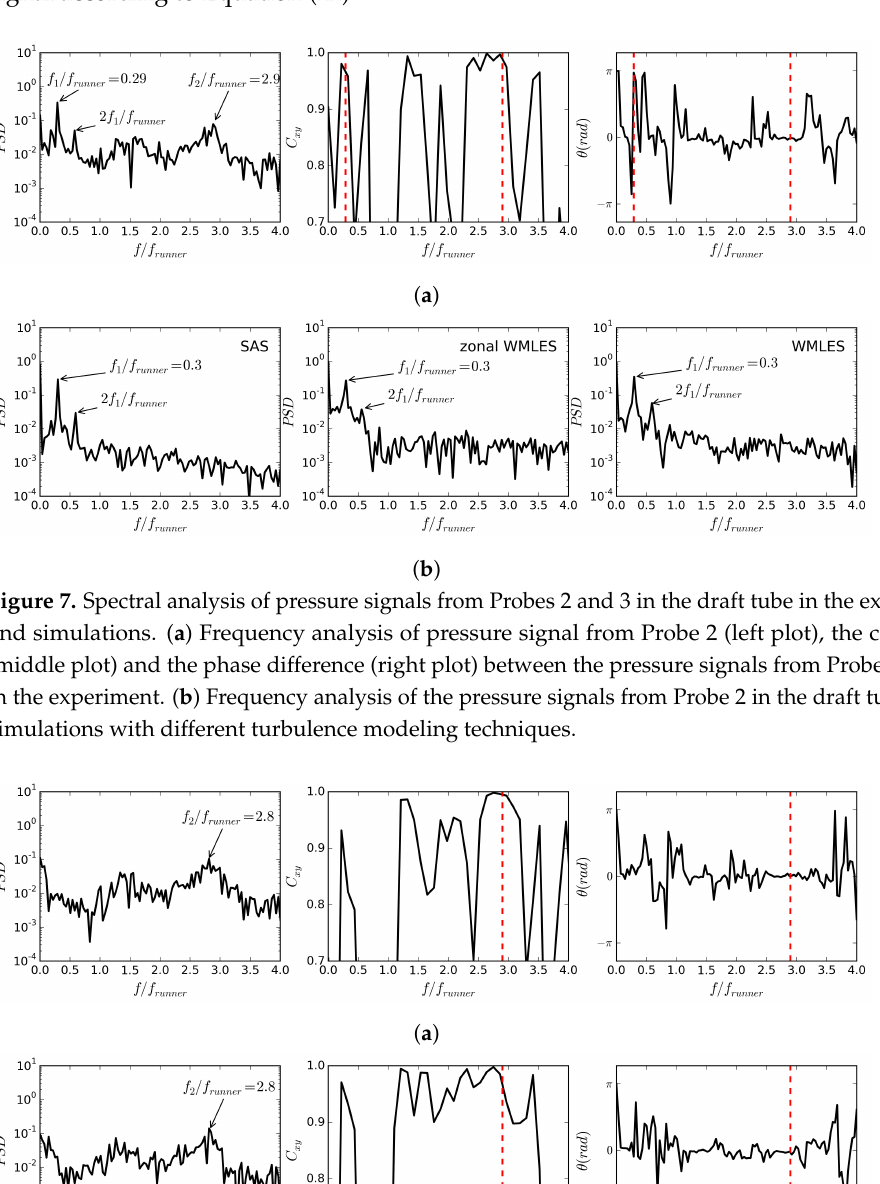
Figure 7a. Based on this assumption, the frequencies of pressure fluctuations due to RVR are determined. These frequencies are then filtered from the signal of pressure fluctuations to obtain the pressure fluctuations due to other sources, p (cid:48) p (cid:48) , then can be obtained by subtracting p (cid:48) RVR signal according to Equation (22).